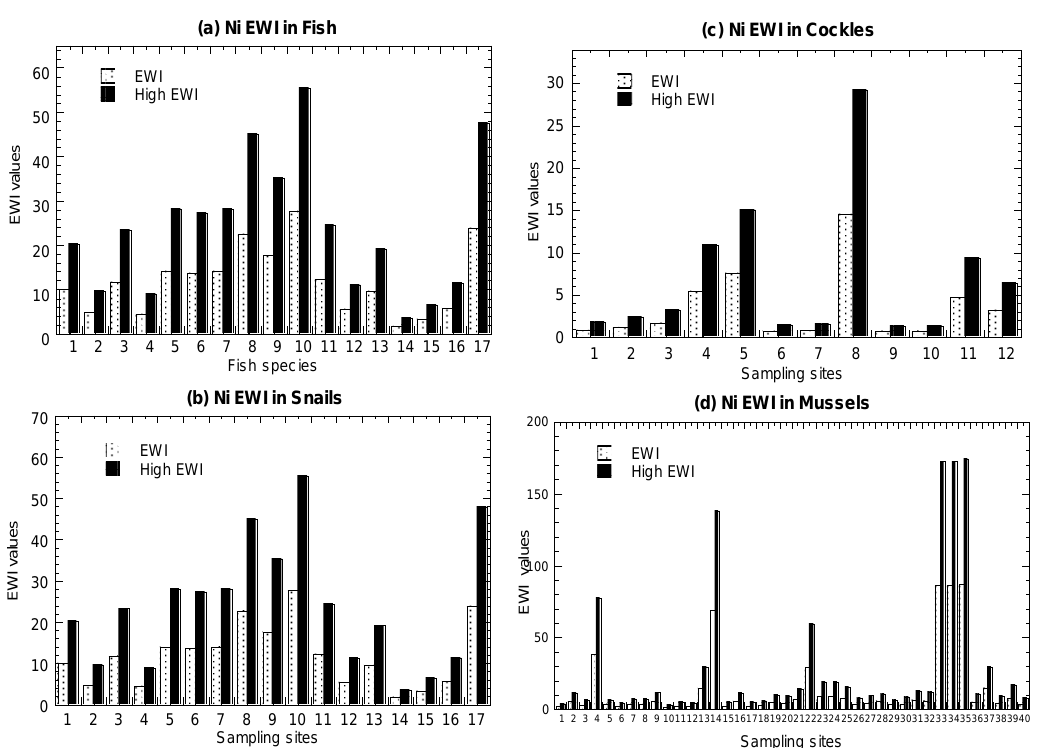
Figure 5. Values of average estimated weekly intake (EWI) and high-level estimated weekly intake (High EWI) of nickel (Ni) in the ( a ) marine fish (1–19), ( b ) mangrove snail Cerithidea obtusa (1–17), ( c ) cockle Anadara granosa (1–12), and ( d ) marine mussel Perna viridis (1–40) cited from Yap et al. [35]. Note: With provisional tolerable weekly intake (PTWI) for Ni as 91 µg/kg body weight/week [67], the Ni PTWI for 62 kg body weight for an average adult in Malaysia is equivalent to 5642 µg/week. The high-level consumers (2 times of consumption rate of average-level consumers) are indicated by High.